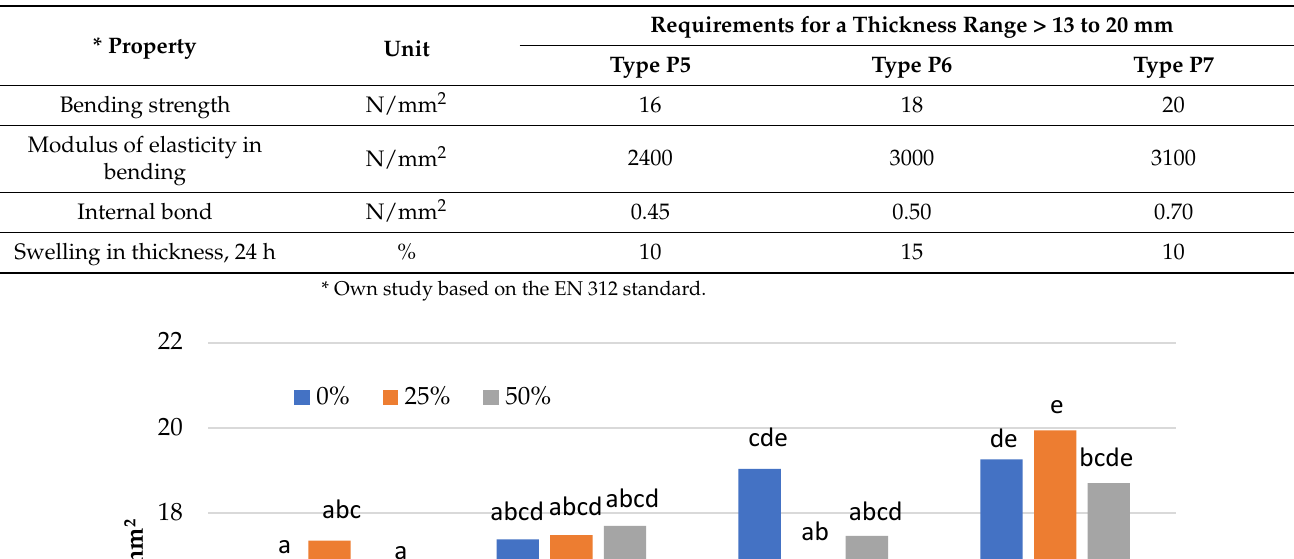
Table 3. Requirements in terms of mechanical properties and swelling for particleboards.